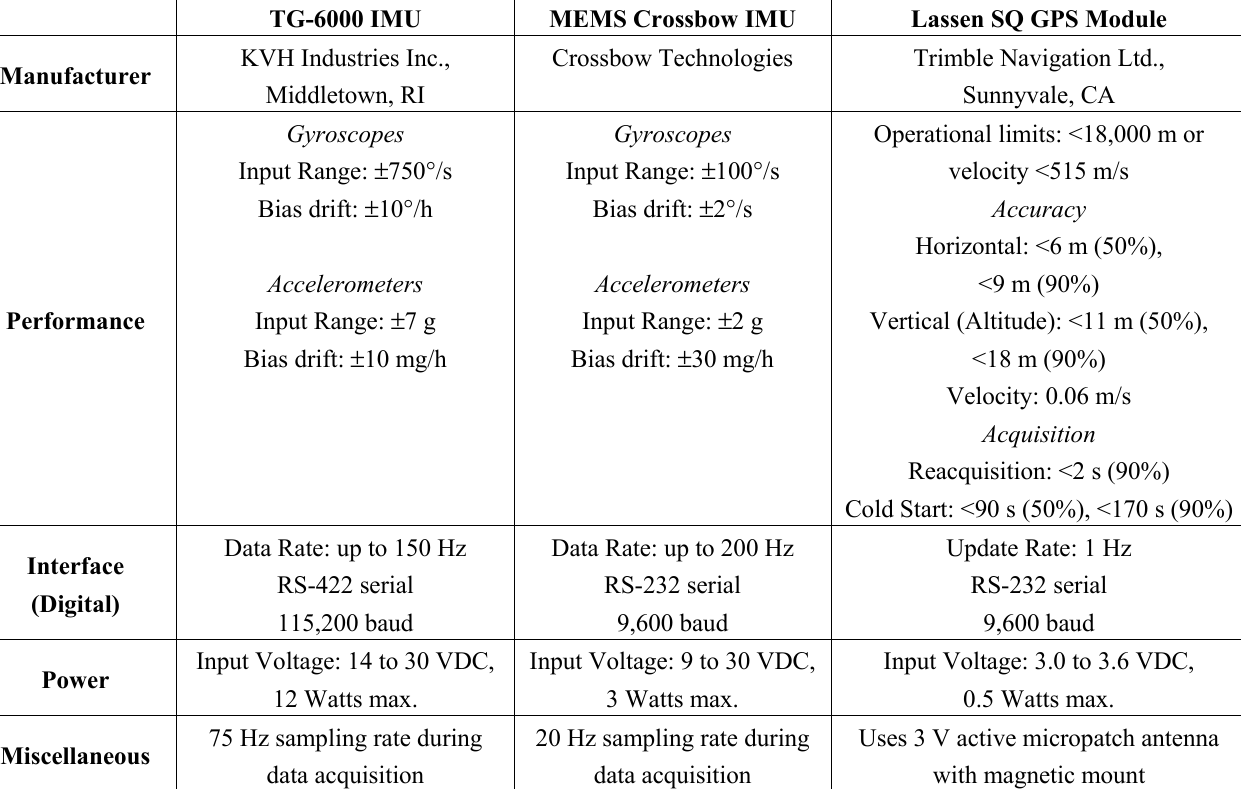
Table 4. Specifications for TG-6000 IMU and Lassen SQ GPS